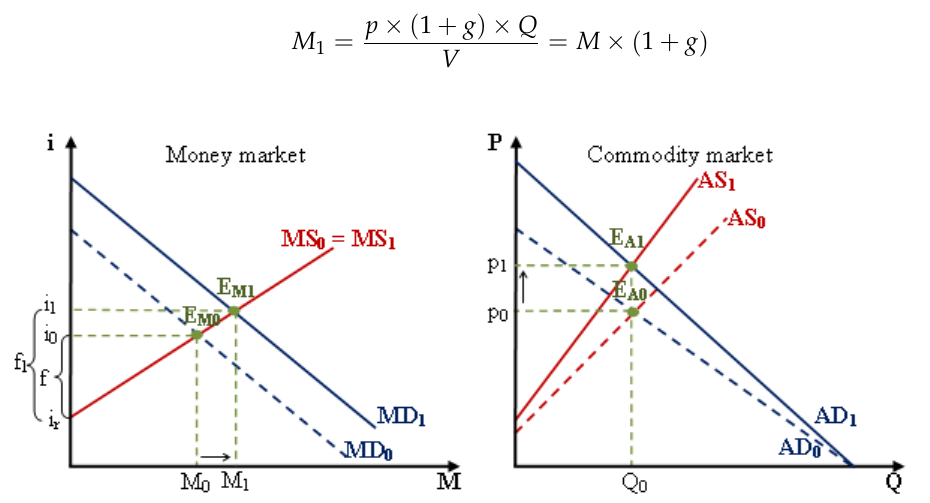
Figure 6. The full-employment equilibrium economy.